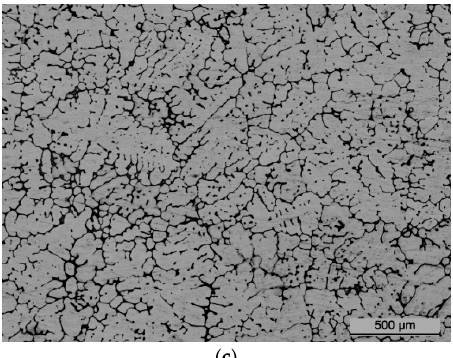
Figure 1. Optical micrographs of as-cast 2219 aluminum alloys with different Cu contents: ( a ) 5.56%, ( b ) 6.15%, ( c ) 6.52%.